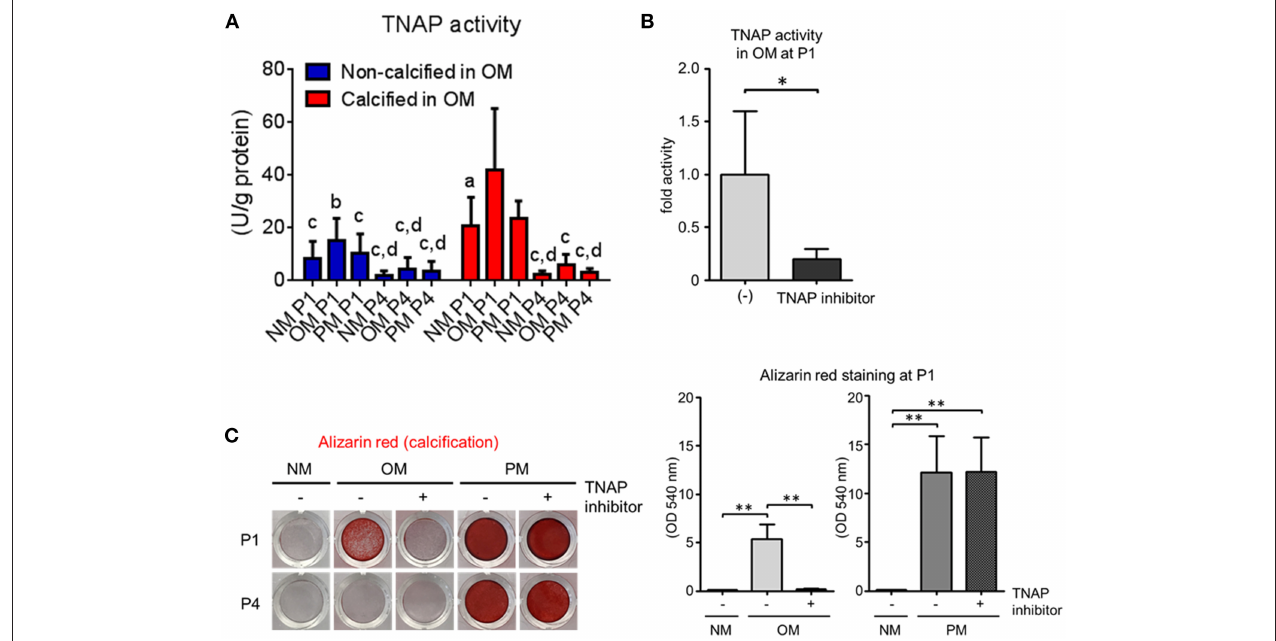
FIGURE 8 | Tissue non-specific alkaline phosphatase (TNAP) regulates passage-dependent calcification in VICs in OM. (A) Passage one (P1) and passage four (P4) TNAP activity of calcification-prone (calcified at P1 in OM) and calcification resistant (non-calcified at P1 in OM) in NM, OM, and PM; n = 5 donors/group, a P < 0.05, b P < 0.001, c P < 0.0001 when compared to calcified OM P1 group, and d P < 0.05 when compared to calcified PM P1 group, analyzed by ANOVA with Tukey’s multiple comparison test, error bars indicate SD. (B) TNAP activity at P1 in VICs in OM or OM with TNAP inhibitor; n = 5 donors, * P < 0.05 analyzed by t -test, error bars indicate SD. (C) P1 Alizarin red stain and quantification for VICs in NM, OM, or PM with or without TNAP inhibitor; n = 3 donors, ** P < 0.01 analyzed by ANOVA with Tukey’s multiple comparison test, error bars indicate SD.